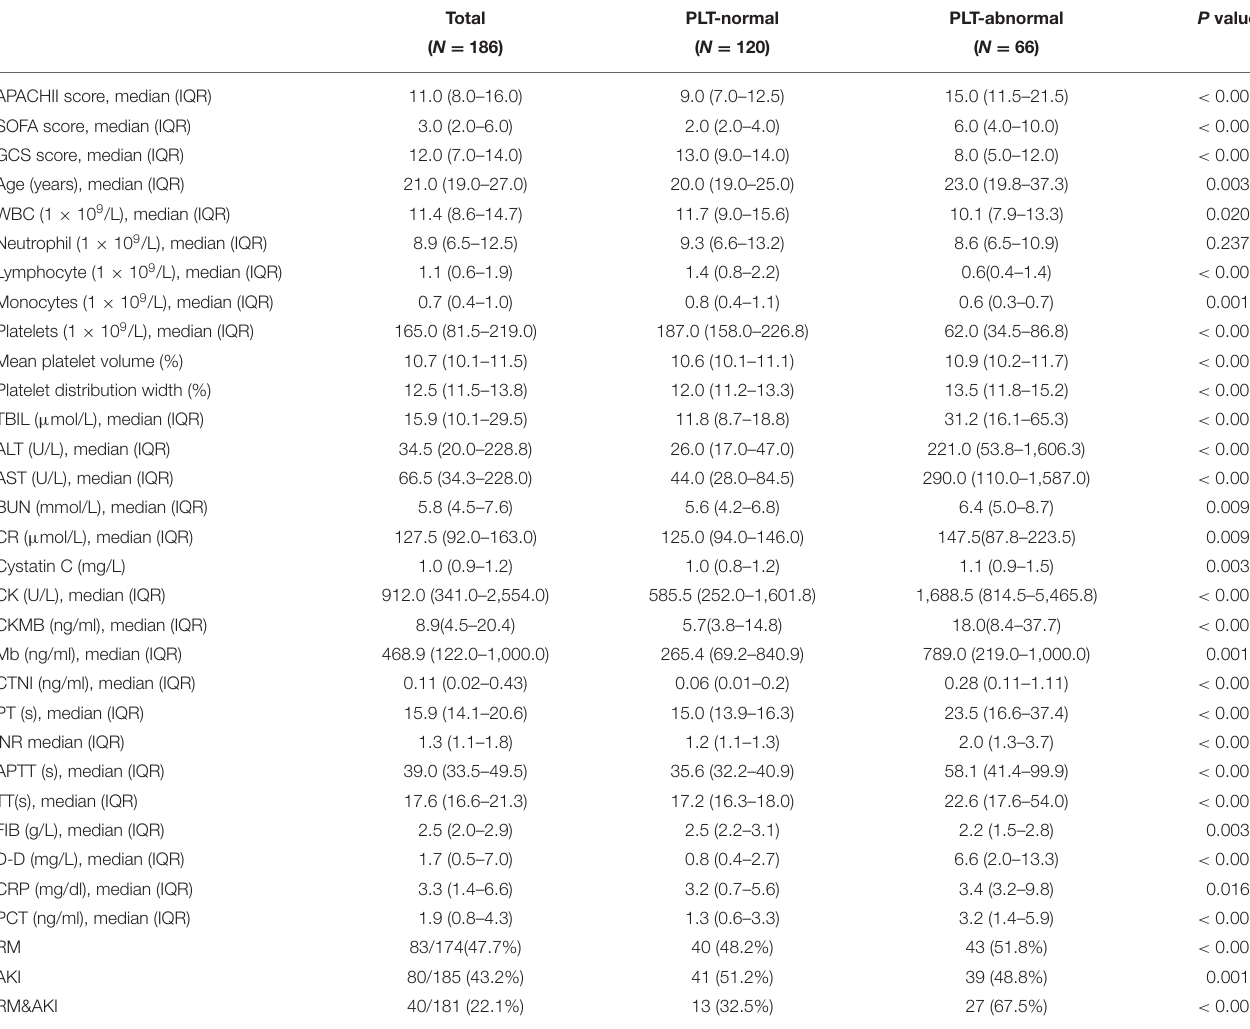
TABLE 1 | Baseline characteristics of clinical and laboratory findings in PLT-normal group and PLT-abnormal